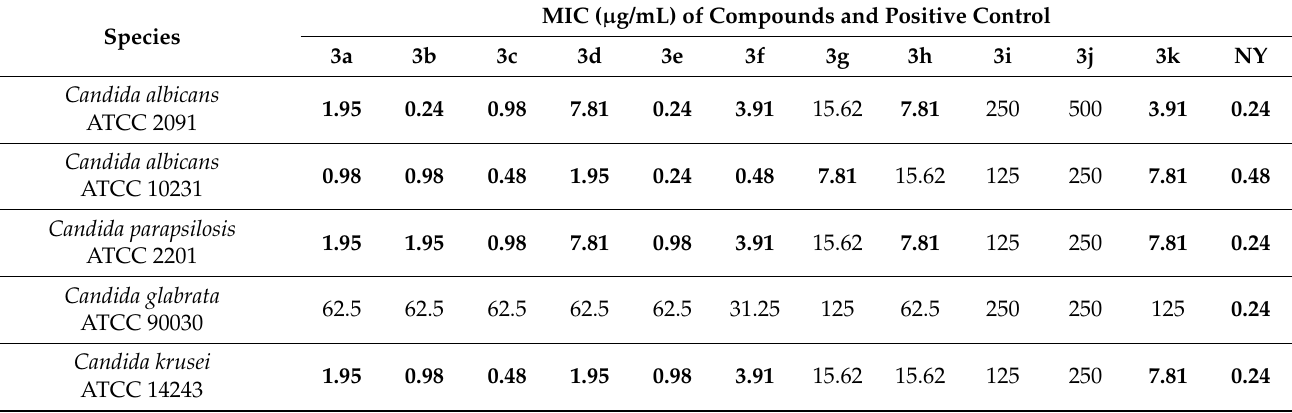
Table 3. The activity data of compounds expressed as MIC ( µ g/mL) against the reference strains of fungi. The standard antibiotic—nystatin (NY) was used as positive control.